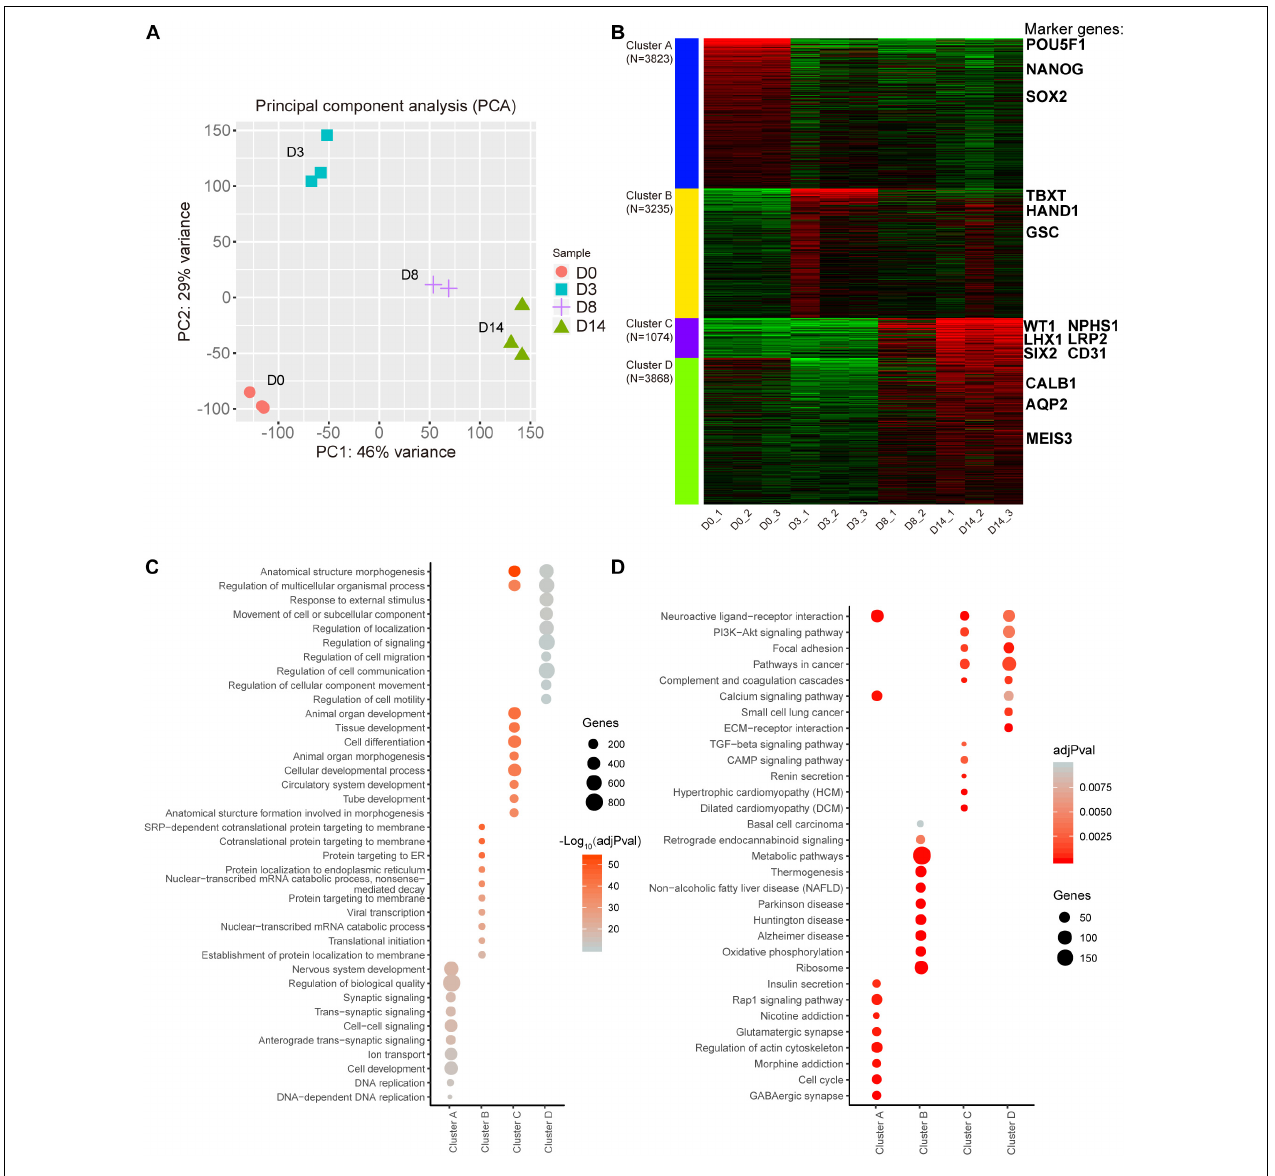
FIGURE 2 | Transcription profiling of the kidney organoid differentiation process. (A) Scores plot for transcriptome samples in the PCA analysis. (B) k-Means clustering of expressed genes during different differentiation phases (the top 12,000 variable genes were used). Known markers of kidney development are highlighted. (C) Top 10 overrepresented GO terms in each cluster with functions in biological processes. (D) Top 10 enriched pathways in each cluster based on KEGG pathway enrichment analysis. Pathways with adjusted P -value (adjPval) below 0.01 (2C and